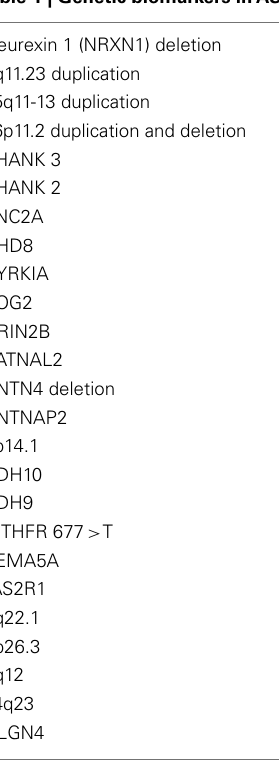
Table 1 | Genetic biomarkers inASD (see text for references)